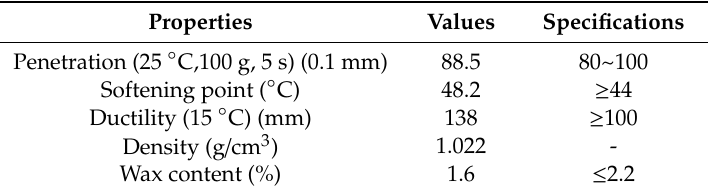
Table 1. The main properties of 90# matrix asphalt.